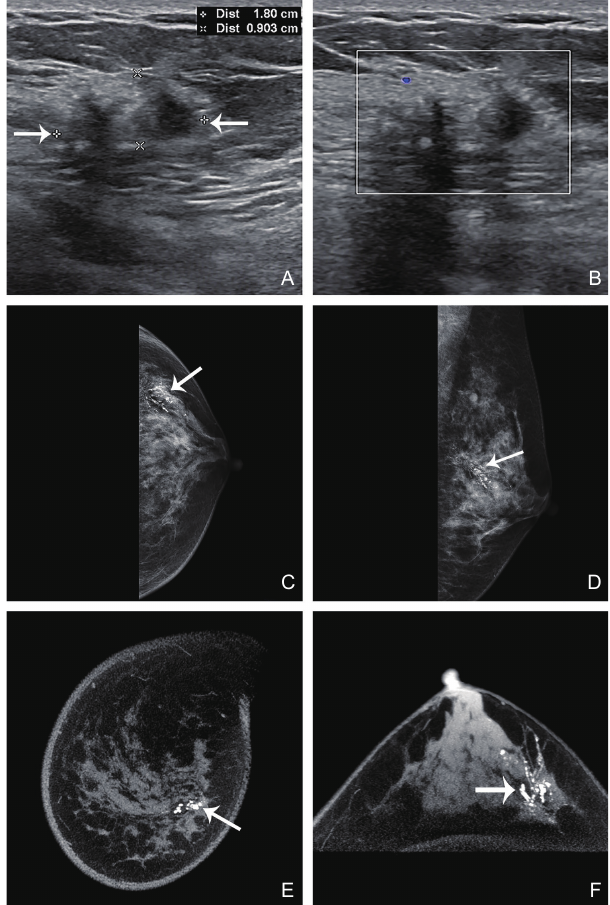
Figure 1 A 29-year-old women with a left breast lesion which was confirmed as invasive breast cancer. After completion of neoadjuvant chemotherapy, Transverse ultrasound (A and B) showed a heterogeneous hypoechoic lesion (arrows) without blood flow signal, likely reflecting residual tumor. Mammography (C and D) and CT examination (E and F) showed microcalcifications (arrows) correlating with ultrasound findings. Pathological examination after surgery confirmed residual